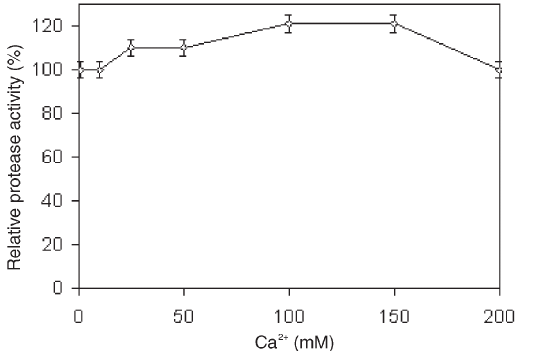
Figure 6. Effect of Ca 2+ on purified protease activity. The enzyme was incubated with different concentrations of Ca 2+ at 60 °C, 20% NaCl and pH 10.0, and the relative activity was measured. Each value repre- sents the mean ± SE of three independent